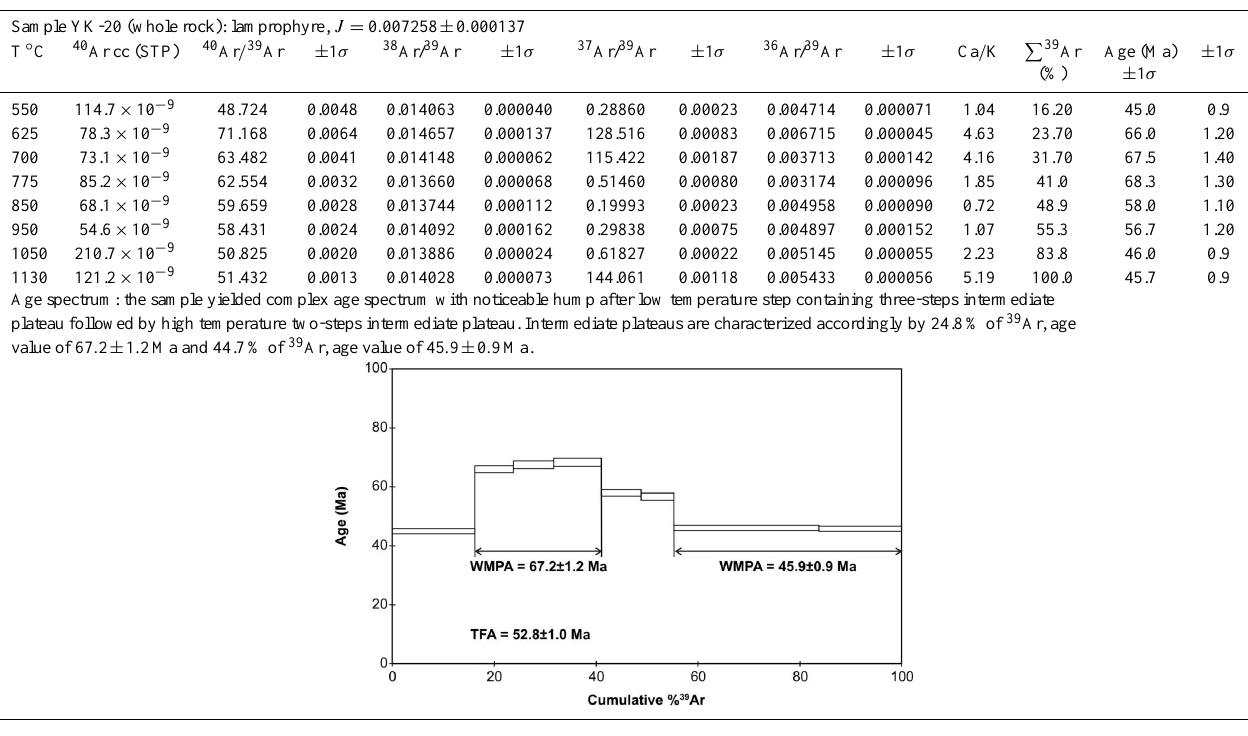
Table 4c. Whole-rock 40 Ar / 39 Ar age data for a lamprophyre dike (sample no. YK-20) from the island arc unit in the Ankara Mélange, Turkey.